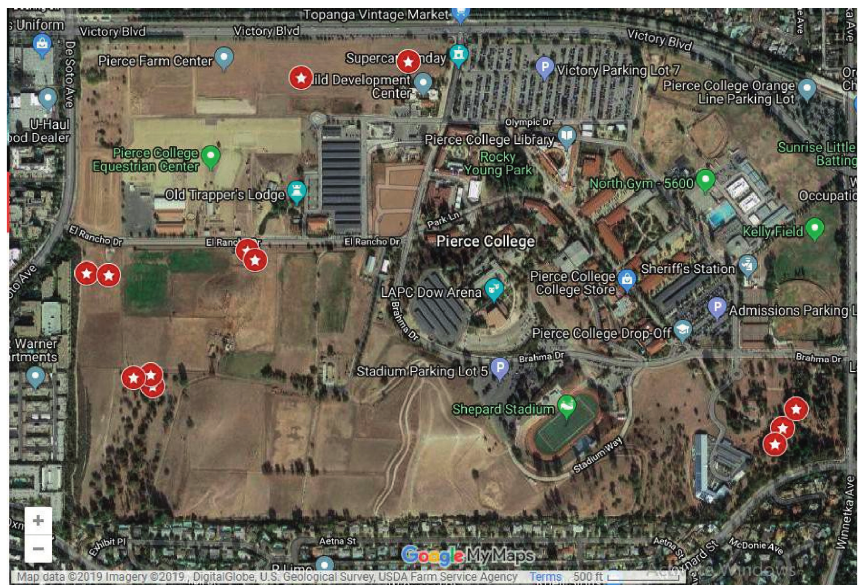
Figure 1: Soil sampling locations at Pierce College indicated with a star symbol. The metadata that were paired with the 16S DNA sequences came from an average of the data points for 2016–2018. The NPK was supplemented from 2018–2019 data. NPK results for Field 19 were averaged from 4 samples in Spring 2016–Fall 2016. The sampling location for Field 19 is shown in Figure 2. Table 4 shows selected metadata for the 16S isolates.